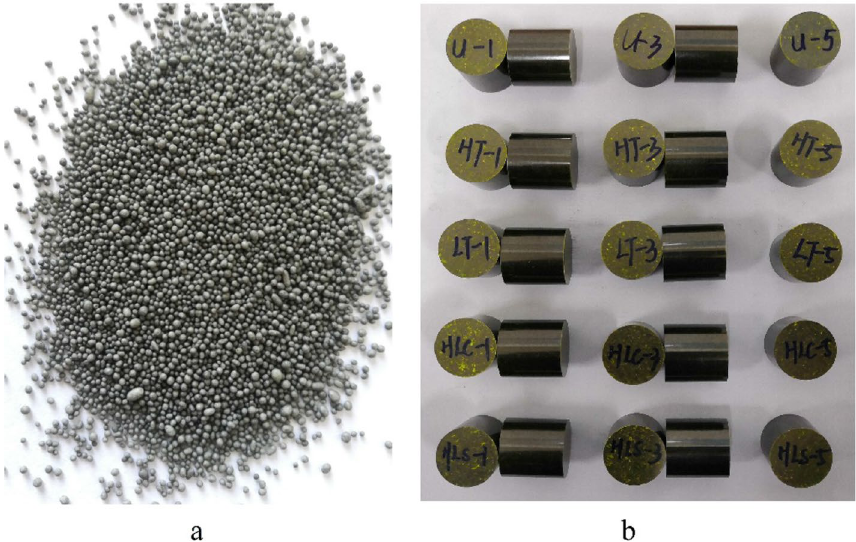
Figure 1. ( a ) HNIW/FOX-7 based PBX modeling powders, ( b ) HNIW/FOX-7 based PBX